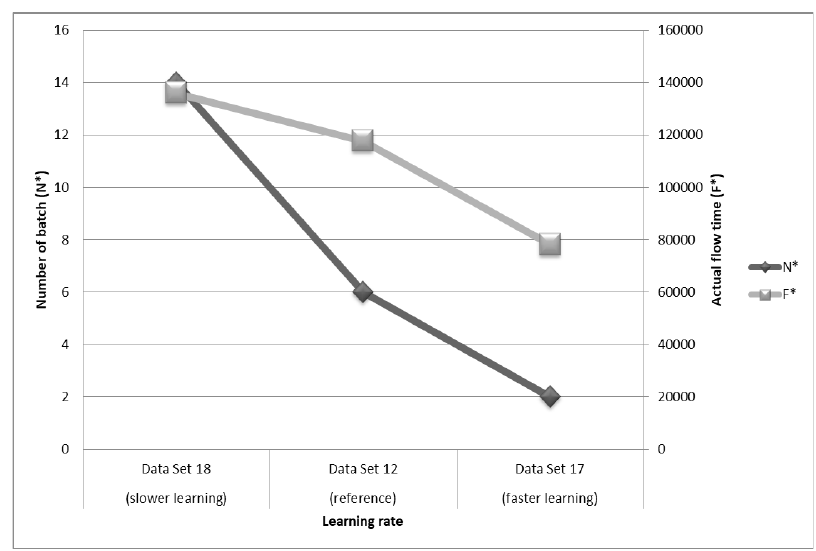
Figure 3. The result of sensitivity analysis on learning